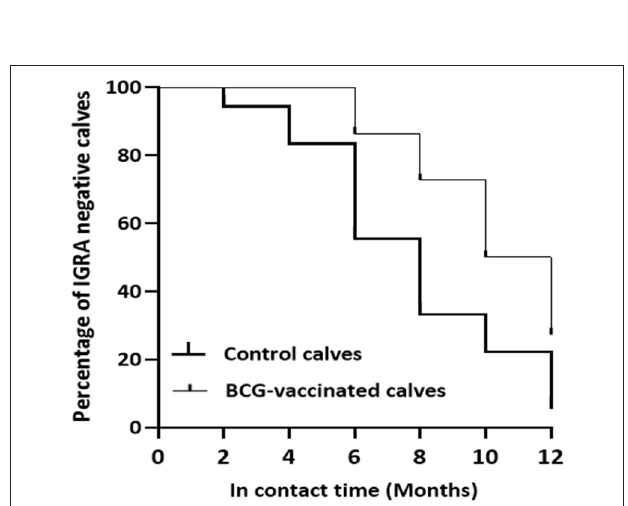
FIGURE 9 | Survival of the experimental calves from Mycobacterium bovis infection. The figure shows reduction in the percentages of specific peptides cocktail-based IGRA negative calves in the vaccinated and control groups during exposure. The thick line curve represents the control calves while the thin line curve for the control calves. There was a significant difference (Log-rank test: χ 2 = 6.749, P < 0.01) in the rate of survival from M. bovis infection between the vaccinated and control